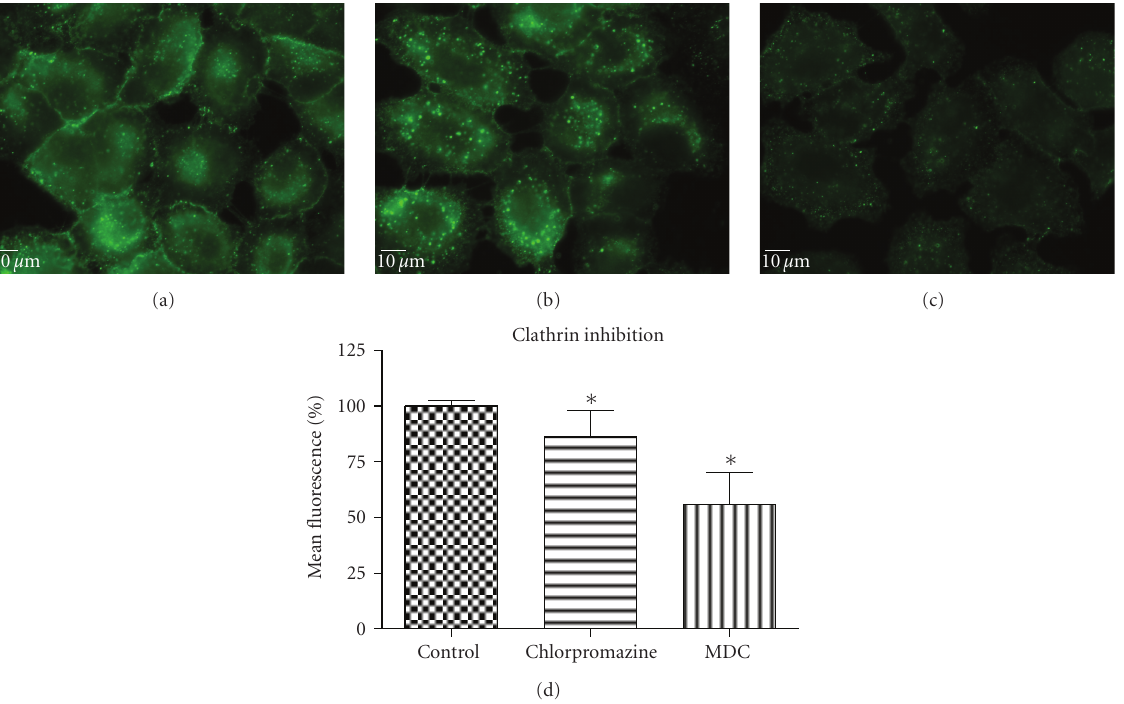
Figure 7: E ff ect of clathrin inhibitors on QD/SR9 internalization (150 nM; 1:20; 1 hour). (a) Control cells. (b) Cells pretreated with chlorpromazine for 30 min then incubated with QD/SR9 for an additional 1 hour. (c) Cells pretreated with MDC for 30min then incubated with QD/SR9 for an additional 1 hour. Images are from a single plane of Z series. (d) Fluorescence intensity. Values are mean ± SD from three independent experiments ( ∗ P (cid:5) s < . 01 versus